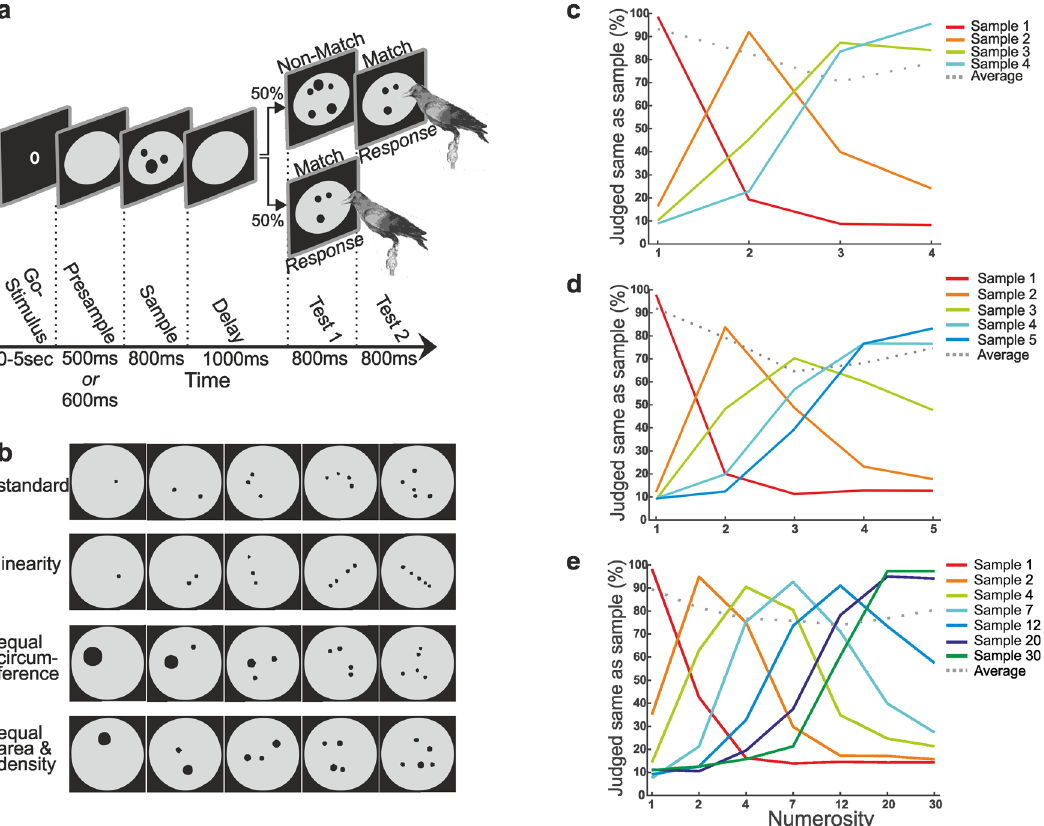
Fig. 1 Delayed match to numerosity task and behavioral performance. a Behavioral protocol. The crows had to move their heads into an infrared light barrier when the go-stimulus appeared to start a trail. The fi rst display contained 1 – 4, 1 – 5 (small numerosities) or 1 – 30 items (large numerosities) and was shown as 800 ms. The crows had to memorize this numerosity for 1000 ms over the delay period and match it to the subsequent test display. In 50% of the cases, the test contained the same number of items as the sample (match). By pecking on the screen, the crows indicated the match and received a reward. In nonmatch trials, the crows had to refrain from pecking on the screen until a second display appeared, which was always a match. b A small subset of the stimulus displays are shown as examples. The physical appearance of the displays varied widely for the same quantities for the numerosity set 1 – 5. c, d, e Behavioral performance in experiments with four ( c ), fi ve ( d ), and 30 numerosities ( e ). The colors of the curves represent performance curves for a given sample numerosity. The average performance for each numerosity is shown in gray as the percentage correct (chance level, 50%).